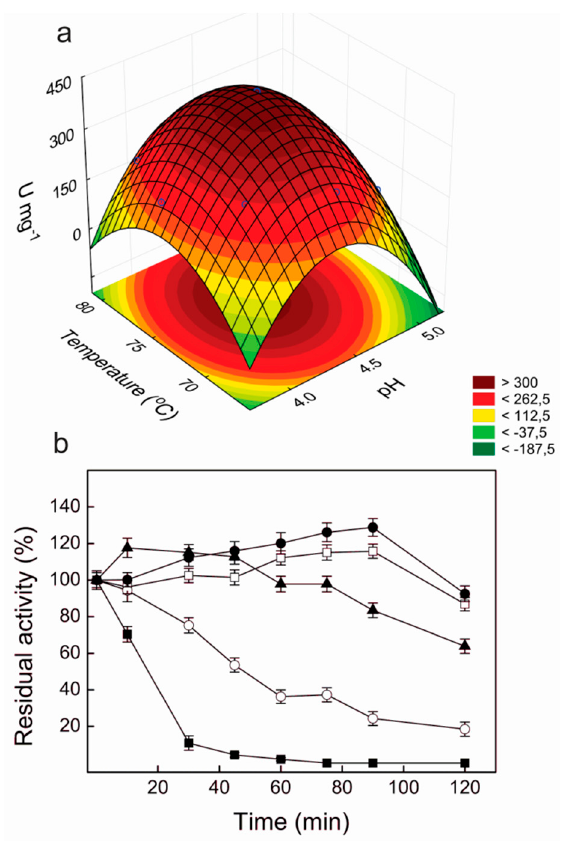
Figure 3. Response surface curve for the effects of pH and temperature on laccase activity ( a ), and thermal stability of the purified Lacps1 ( b ). In thermal stability studies ( b ), samples of the purified laccase in water were incubated at 55 °C ( ), 60 °C ( ), 65 °C ( ), 70 °C ( ) or 75 °C ( ), and the residual activities were determined at 65 °C in McIlvaine buffer, pH 4.5, containing 1.0 mmol·L − 1 ABTS. One hundred percent specific activity corresponded to 401.4 ± 17.9 U·mg − 1 . The values presented correspond to means ± SD from triplicate experiments ( n = 3) performed with three separate preparations of pure Lacps1.